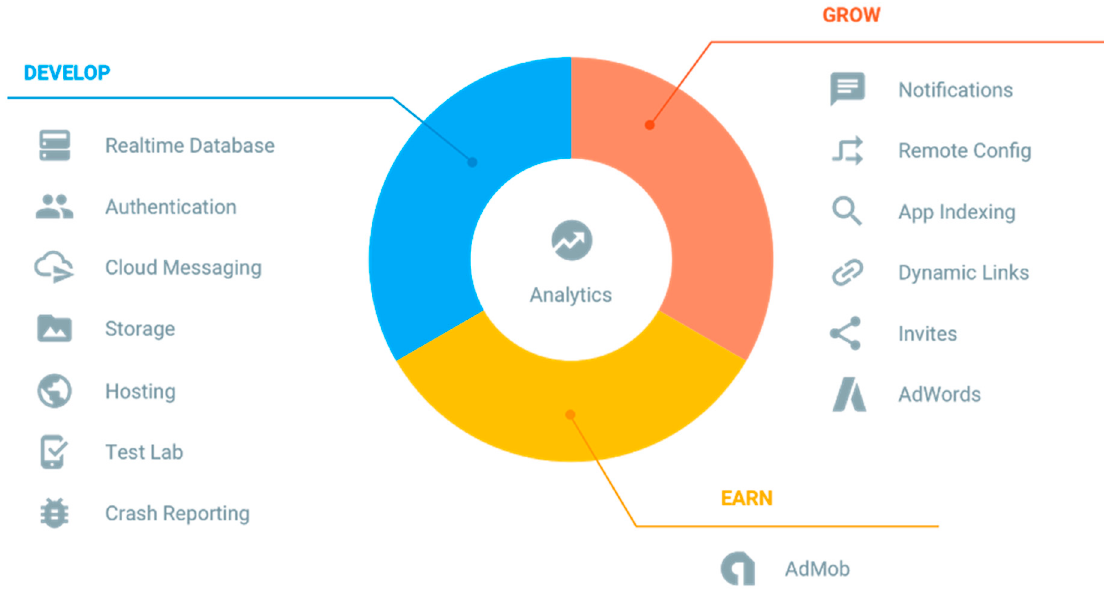
Figure 10. Google Firebase service.